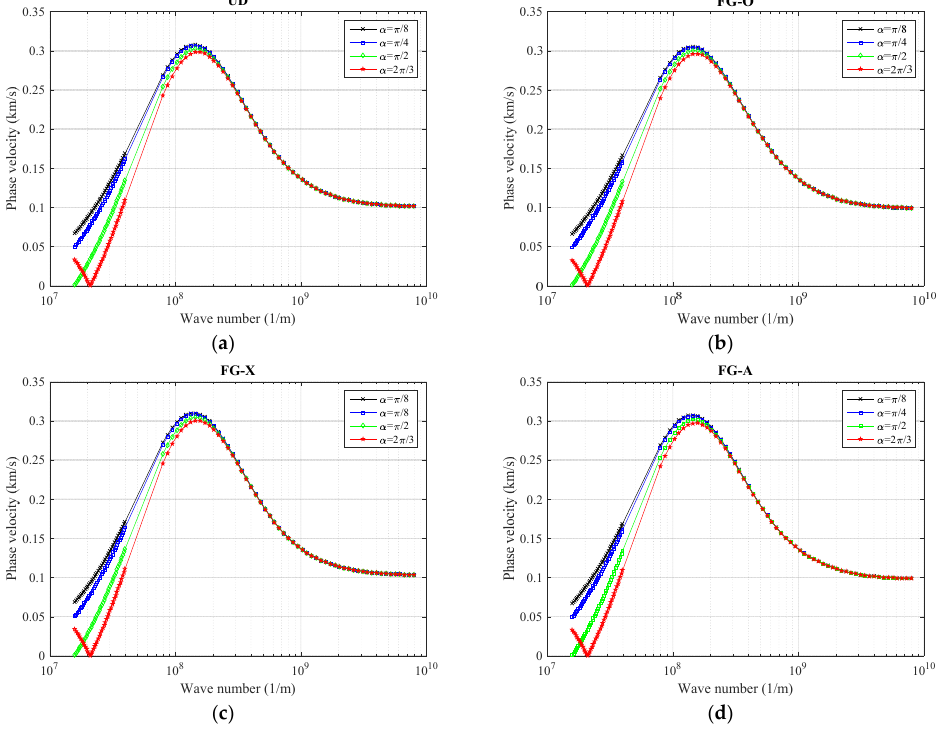
Figure 3. The variation of phase velocity versus opening angle for ( a ) uniform distribution (UD), ( b ) FG-O, ( c ) FG-X, and ( d ) FG-A patterns of GNPs, ( ℓ = 1 nm, μ = 10 nm, g * GNP = 1%, N l = 10).